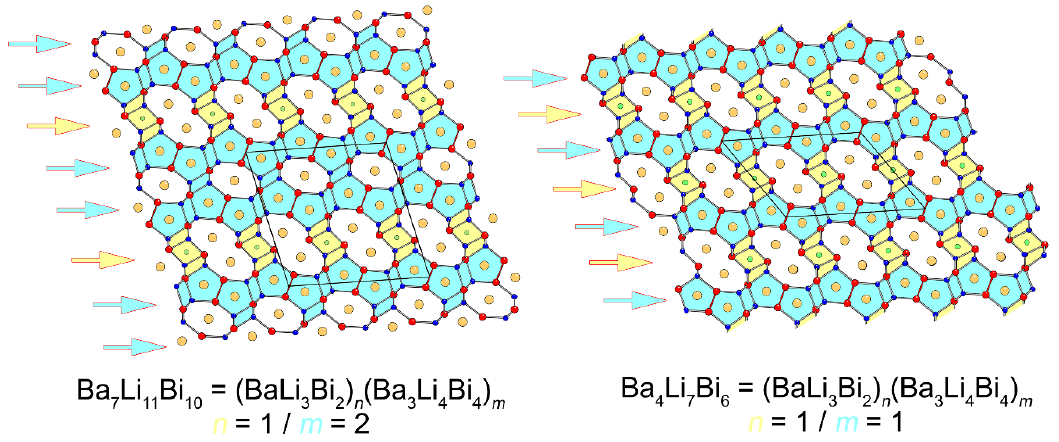
Figure 3. Schematic illustration of the structural relationship between Ba 7 Li 11 Bi 10 and Ba 4 Li 7 Bi 6 , which are considered as intergrowths of the same type of fragments. The slabs cut out from Ba 3 Li 4 Bi 4 (Zr 3 Cu 4 Si 4 structure type) are highlighted in light-blue, and the slabs derived from BaLi 3 Bi 2 (LaLi 3 Sb 2 structure type) are highlighted in yellow.